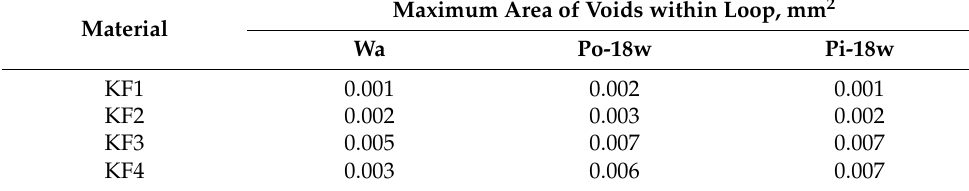
Table 5. The maximum area of